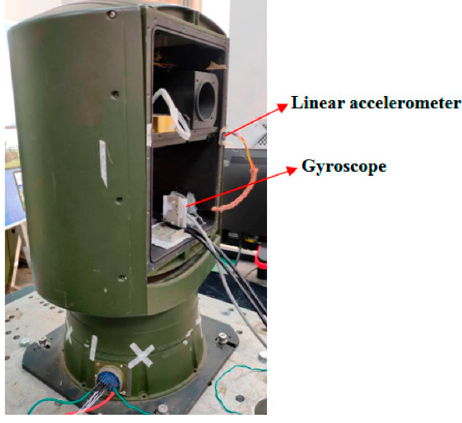
Figure 14. Diagram of the stable